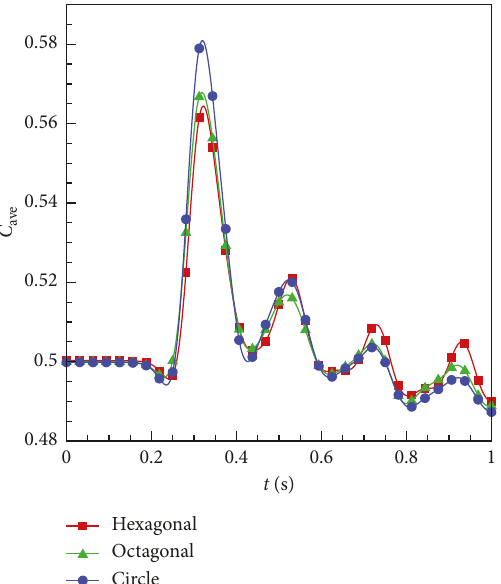
Figure 8: Average concentration variation (mol.m − 3 ) in the three geometries for f � 5, u � 0.1mm · s − 1 , and φ �